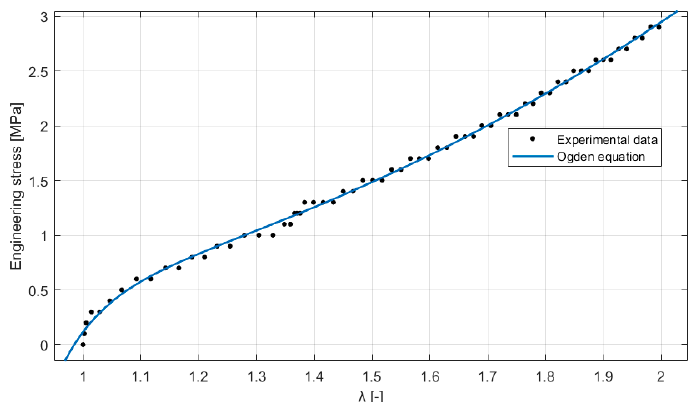
Figure 4. Comparison of tensile test results and Ogden’s incompressible model.